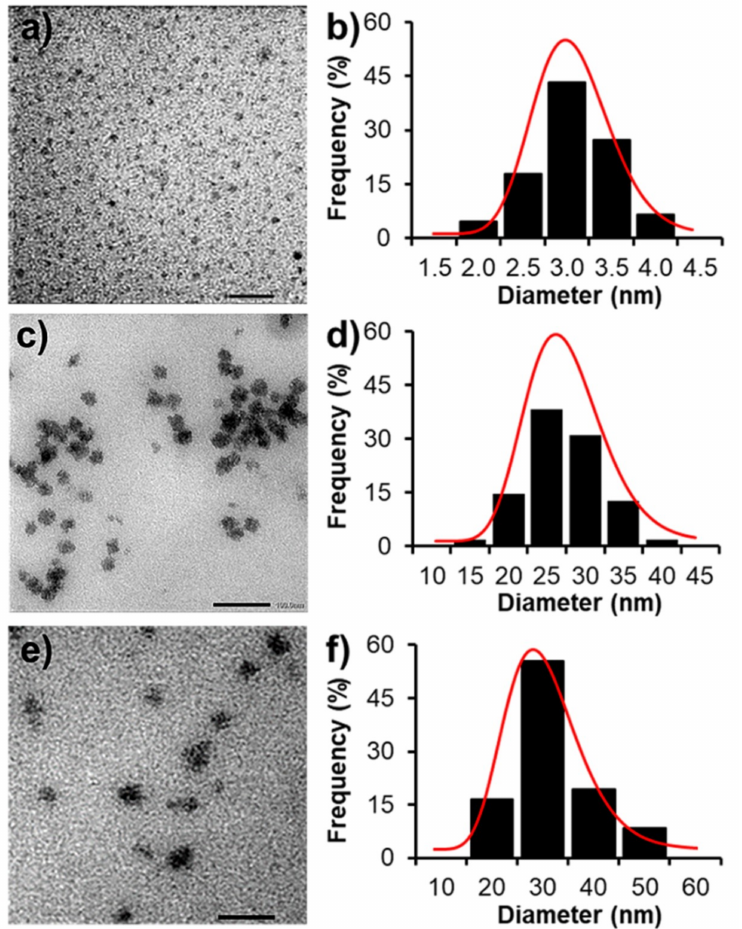
Figure 4. ( a – c ) Transmission electron microscope (TEM) micrographs and ( d – f ) size distribution of PAMAM G3.0 (scale bar = 20 nm) ( a , b ), PAMAM G3.0@mPEG (scale bar = 100 nm) ( c , d ), and CAR / PAMAM G3.0@mPEG (scale bar = 100 nm) ( e , f